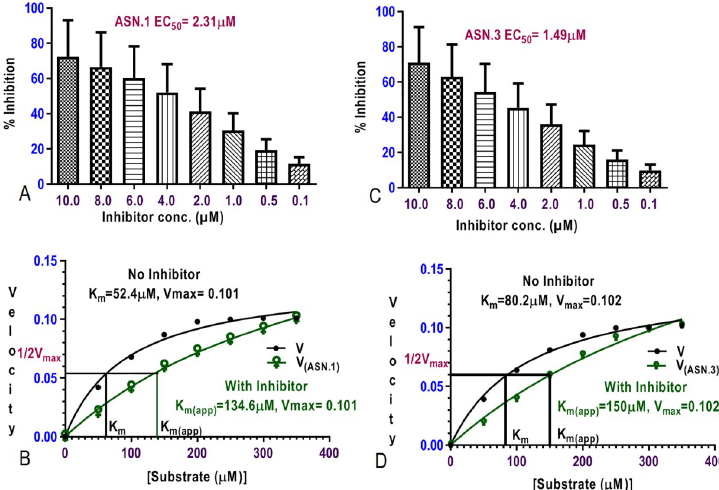
Fig 10. SAM dependent inhibitor assay and kinetics of Pf PMT at 510nm (A) EC 50 of ASN.1 inhibitor against Pf PMT with P � (0.05) (C) inhibitor kinetics of the ASN.1 with 134.6 μ M and (B) EC 50 of ASN.3 inhibitor with P � (D) inhibitor kinetics of the ASN.3 with 150 μ M.